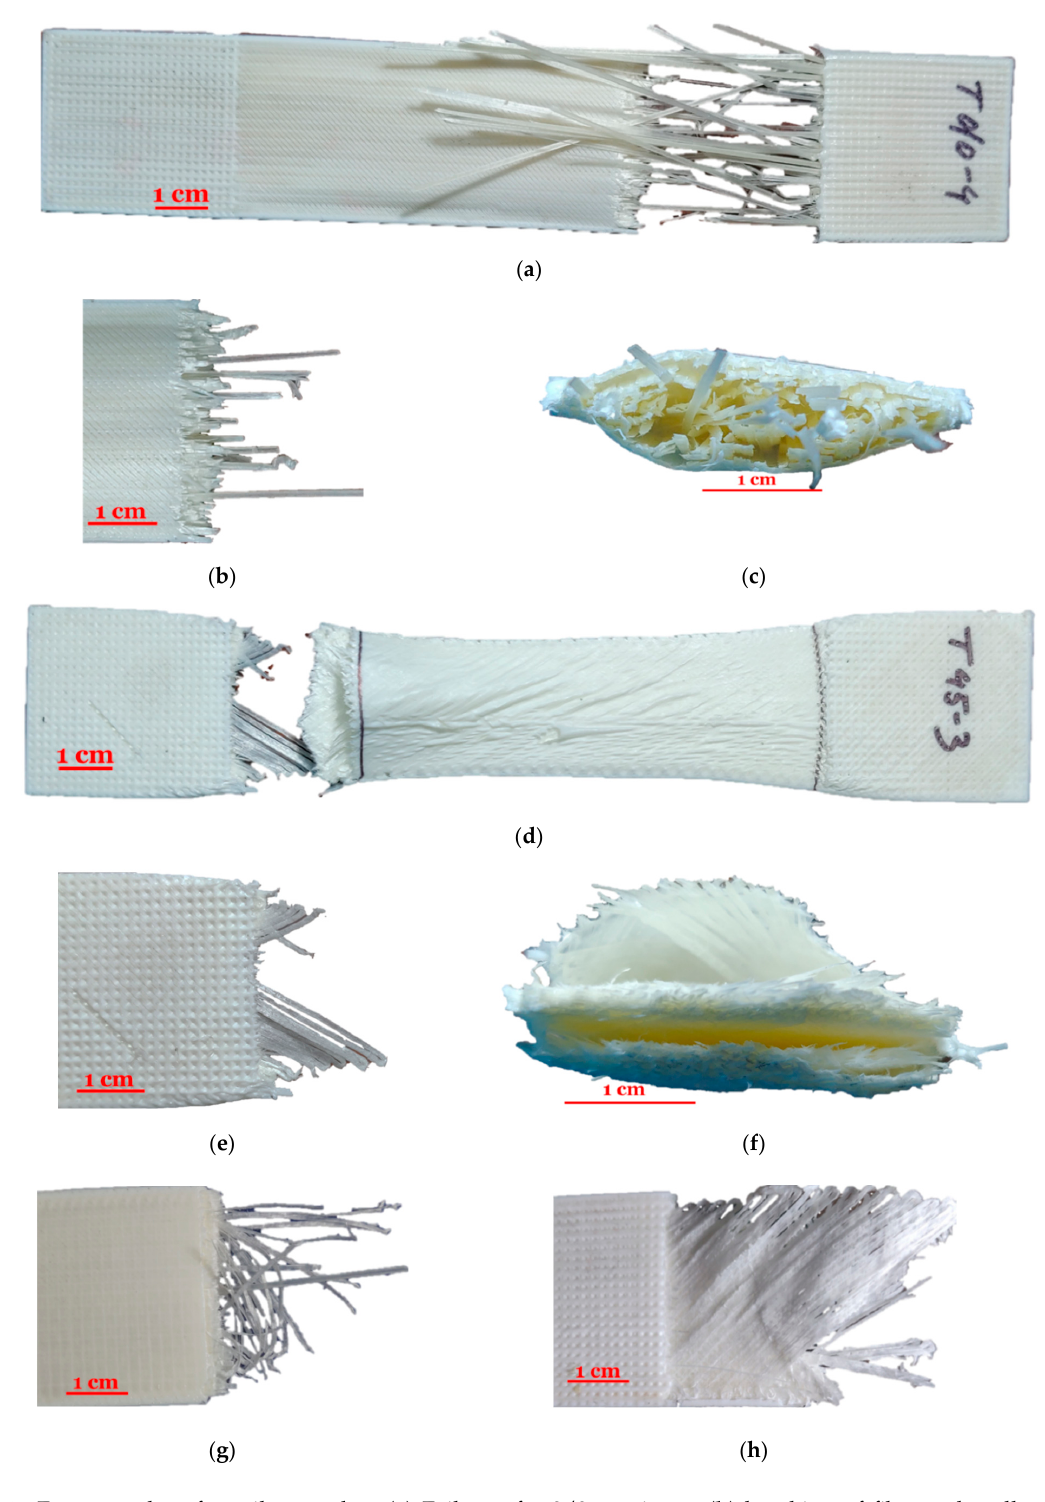
Figure 4. Fractography of tensile samples: ( a ) Failure of a 0/0 specimen, ( b ) breaking of fiber as bundle and fiber bundle pullout, ( c ) magnified cross-sectional view of the fractured specimen, ( d ) failure of a ± 45 specimen, ( e ) interlayer delamination of a ± 45 specimen, ( f ) magnified cross-sectional view of the fractured ± 45 specimen, ( g ) fiber filament pullout of a 0/90 specimen, and ( h ) fiber filament pullout and interlayer delamination of a 0/45/90/ − 45 composite specimen. Comparison of the obtained results (Table 2), with the 3D orthogonal woven (3DOW) and unidirectional (UD) composites having about similar structures, indicated 3DP